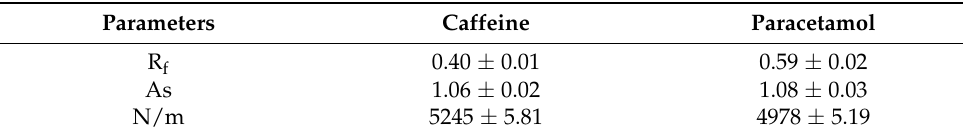
Table 3. System suitability parameters in terms of retardation factor (R f ), asymmetry factor (As), and a number of theoretical plates per meter (N/m) of caffeine and paracetamol for the greener normal-phase HPTLC method (mean ± SD; n = 3).